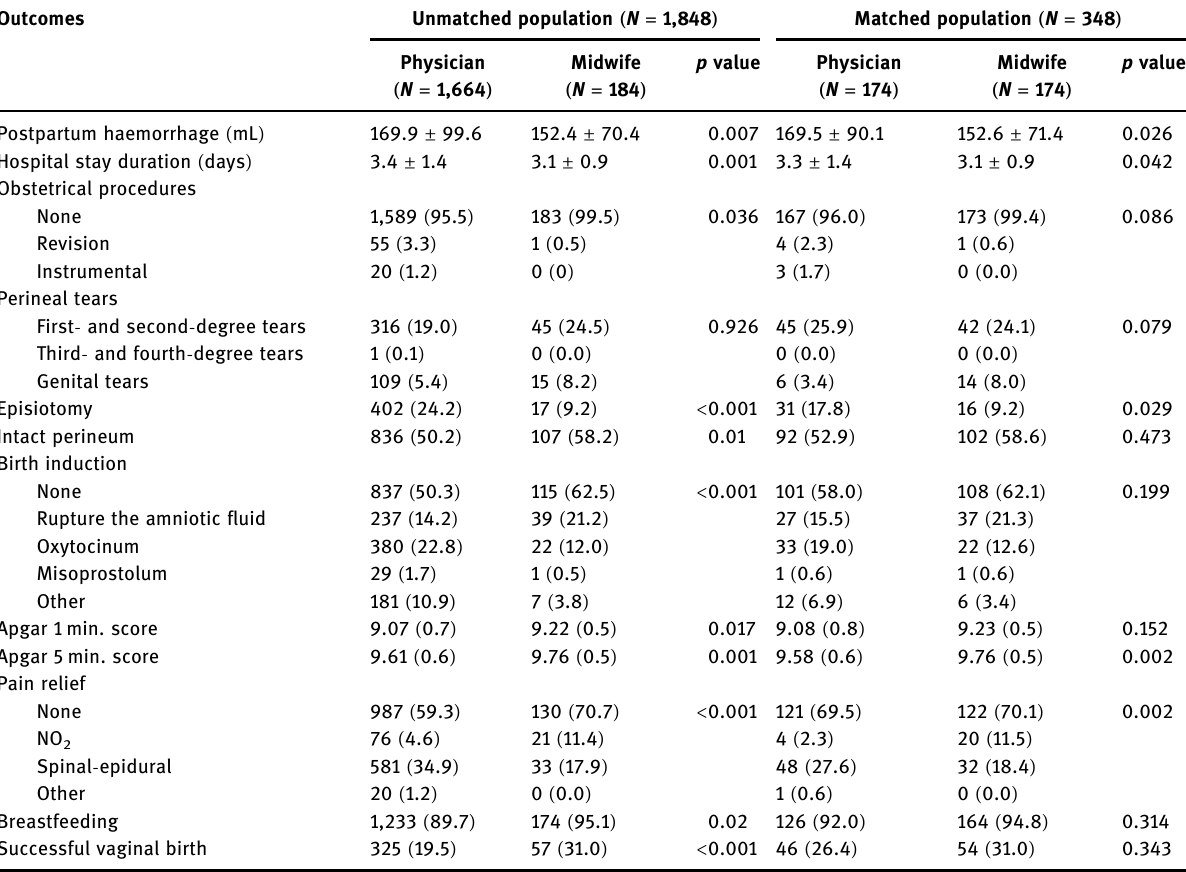
Table 3: Comparison of birth outcomes and services in the unmatched and matched study populations Outcomes Unmatched population ( N = 1,848